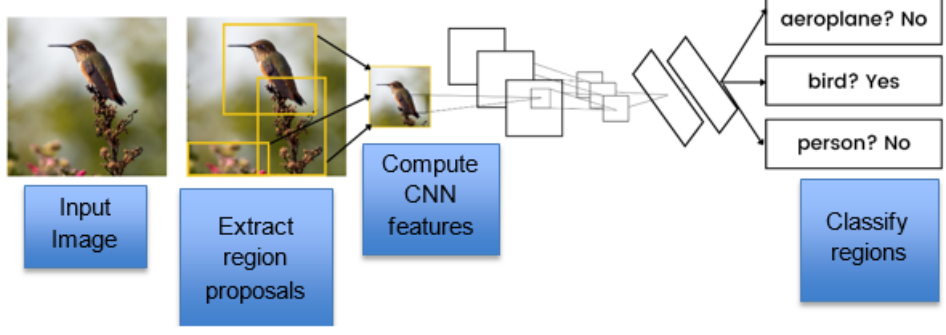
Figure 4. Architecture of R-CNN.